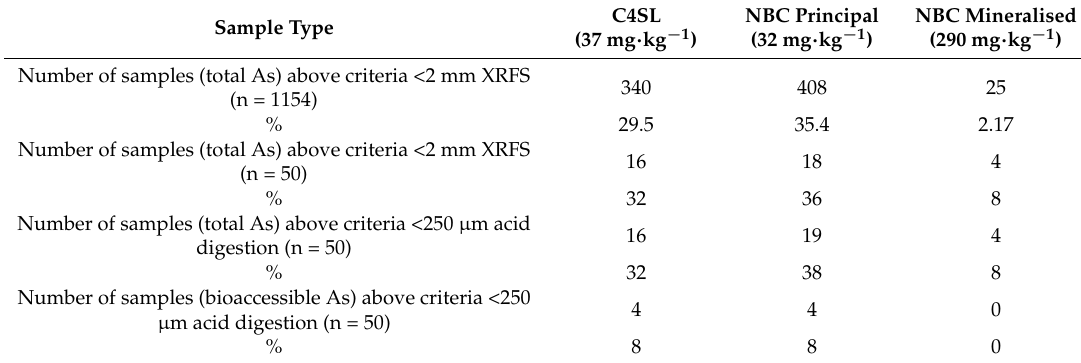
Table 2. Comparison of measured As concentrations assessment